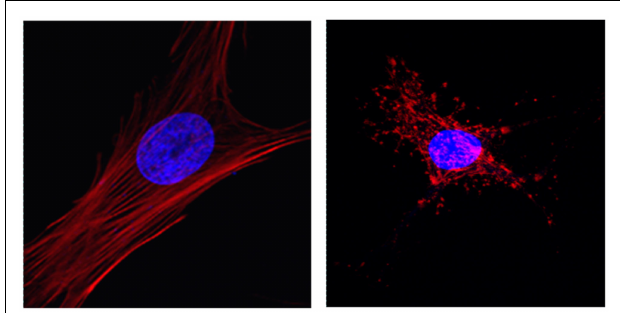
FIGURE 4 | Fluorescent images of the actin network (red) and the nucleus (blue) in primary vascular smooth muscle cells in culture. The left panel demonstrates an intact percolating actin network.The straightness of stress fibers suggests that they are under mechanical tension generated by myosin motors.The right panel shows actin in the presence of cytochalasin D which inhibits the polymerization of the actin monomers to form stress fibers.The transmission of mechanical forces in the absence of a percolating network is highly